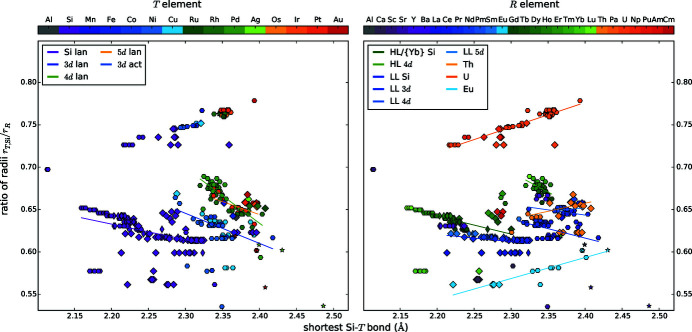
Correlations between the shortest Si—T distance d and the ratio of radii r
T, Si/r
R. Using one regression line for HL and LL compounds the R elements gives an equivalent trend, but using separate lines shows a transition in slope at R = Gd and Y.